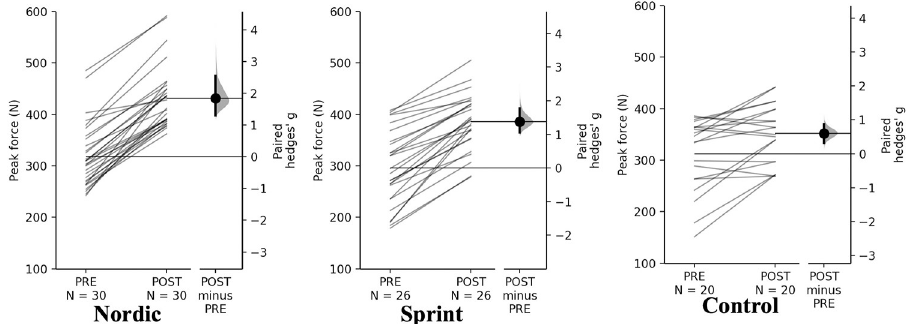
Fig 4. Gardner-Altman estimation plots identifying Pre- and Post-intervention individual changes for peak eccentric hamstring force and Hedge’s g effect size with the 95% CI indicated by the ends of the vertical error bar.